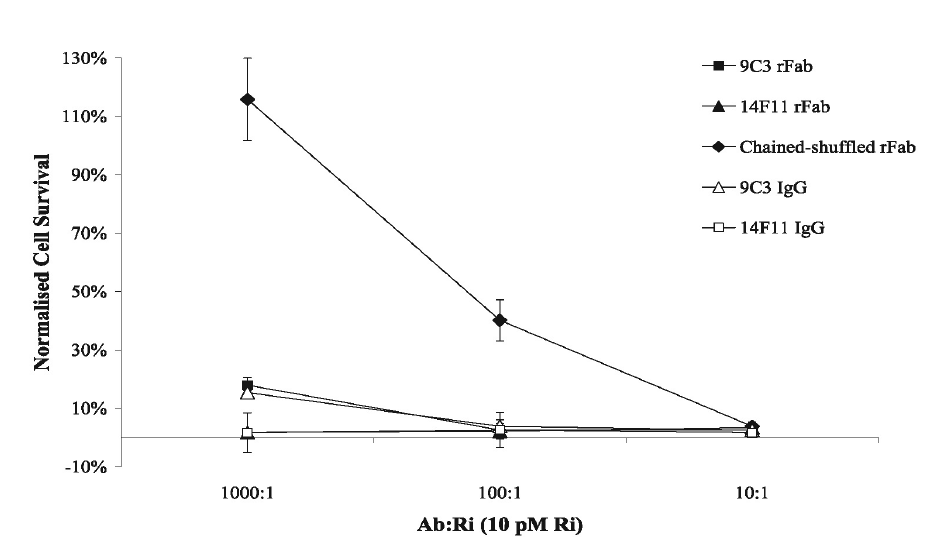
Figure 6. Antibody neutralization of ricin-mediated cellular cytotoxicity. Affinity-purified monoclonal antibody (mAb) was mixed with ricin toxin before incubation with small airway epithelial cells in culture. Cytotoxicity was determined using Neutral Red as a vital stain. The Absorbance at 540 nm was determined for each well and used to calculate cytotoxicity relative to an untreated control (% Control). Means were normalized against cells treated with ricin only and expressed as a percentage of the negative